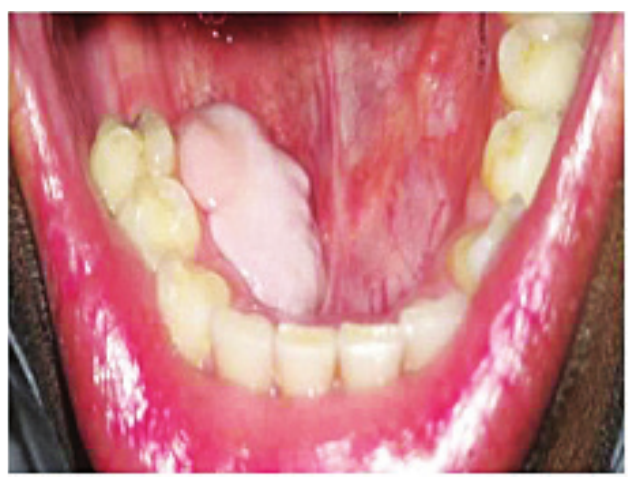
figurE 1 − Initial clinical examination showing the fibroma nodular